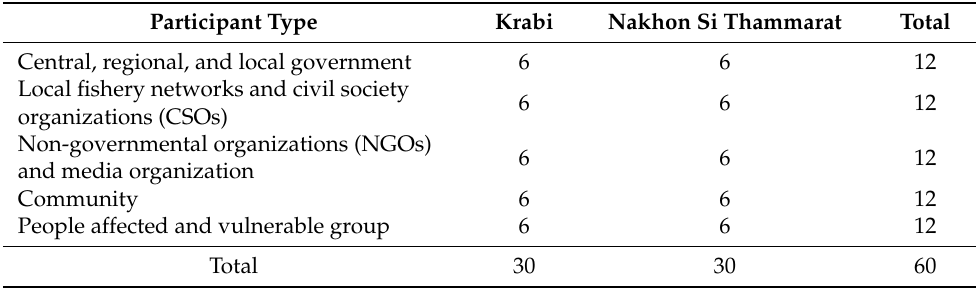
Table 1. Total participants by province.